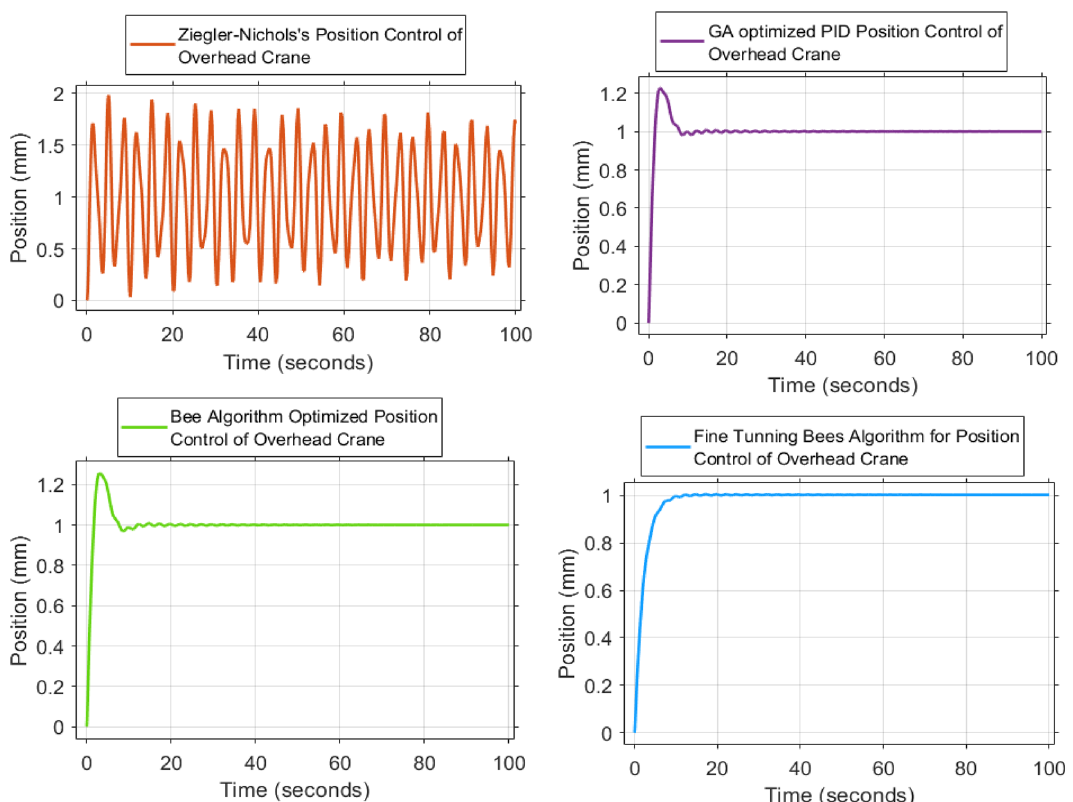
Fig. 5 PID controller result of horizontal motion of overhead crane using different methods at t = 100 s